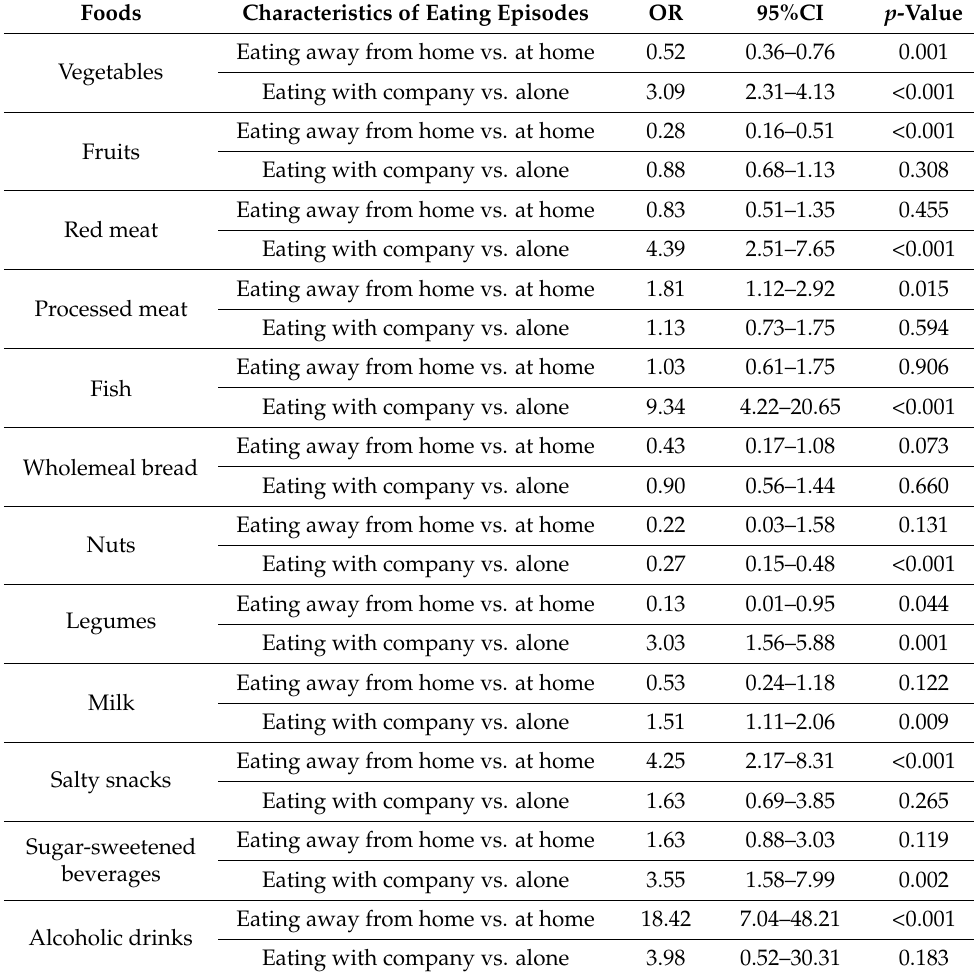
Table 1. Logistic regression analyses of the effect of eating episode environment on the consumption of specific foods. Logistic regression models were adjusted for age, gender, day of the week, meal type, and time of the day in which eating episodes